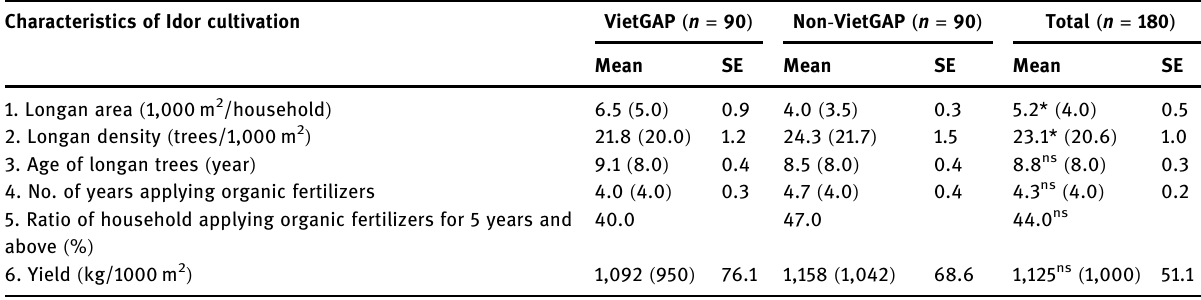
Table 3: Characteristics of Idor longan cultivation in the Mekong Delta, Vietnam Characteristics of Idor cultivation